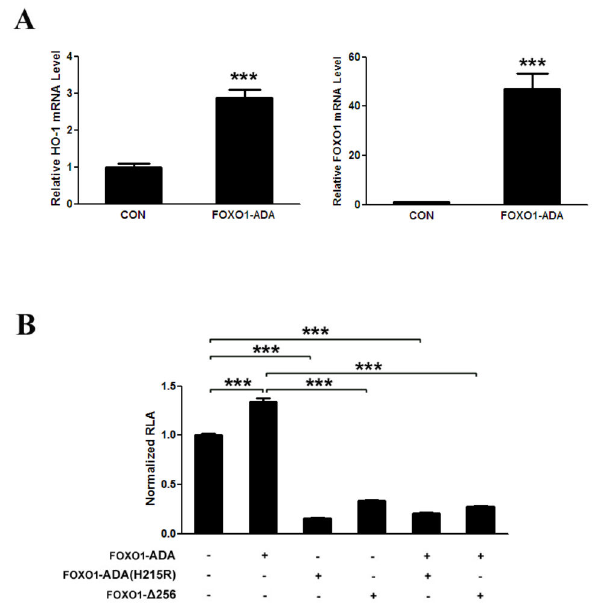
Figure 1. FOXO1 increases the expression of HO-1 dependence on FOXO1 combine to the promoter of HO-1. (A) FOXO1 upregulates HO-1 mRNA in HepG2 cells. HepG2 cells are transfected for 48 h with pcDNA3-FOXO1- ADA and control plasmids, after which cells are harvested, total RNA assays are carried out. HO-1 and FOXO1 mRNA are quantified by qRT-polymerase chain reaction and relative amounts of HO-1 and FOXO1 mRNA are normalized to β-actin mRNA. (B) FOXO1 enhances HO-1 promoter transcription activity dependent on FOXO1 binding to the promoter of HO-1. HepG2 cells are co-transfected with pGL3-Basic-HO-1 promoter (200 ng) and the equivalent amounts of pcDNA3- FOXO1-ADA or/and pcDNA3-FOXO1-ADA (H215R) (pCMV5- FOXO1-Δ256 or control plasmids) as indicated. *** p < 0.001.